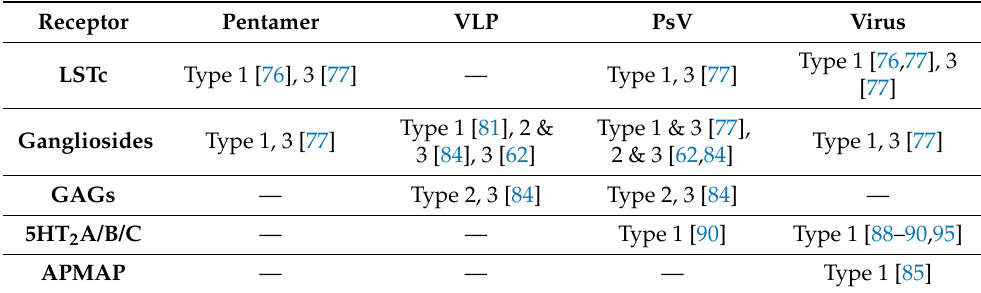
Table 1. Summary of virus-receptor studies for rearranged JCPyV types. Abbreviations are as follows: VLP, Virus-Like Particles; PsV, Pseudovirus; LSTc, LactoSeries Tetrasaccharide C; GAG, GlycosAminoGlycans; 5-HT 2 , 5-HydroxyTryptamine 2; APMAP, Adipocyte Plasma Membrane- Associated Protein. Type is synonymous with